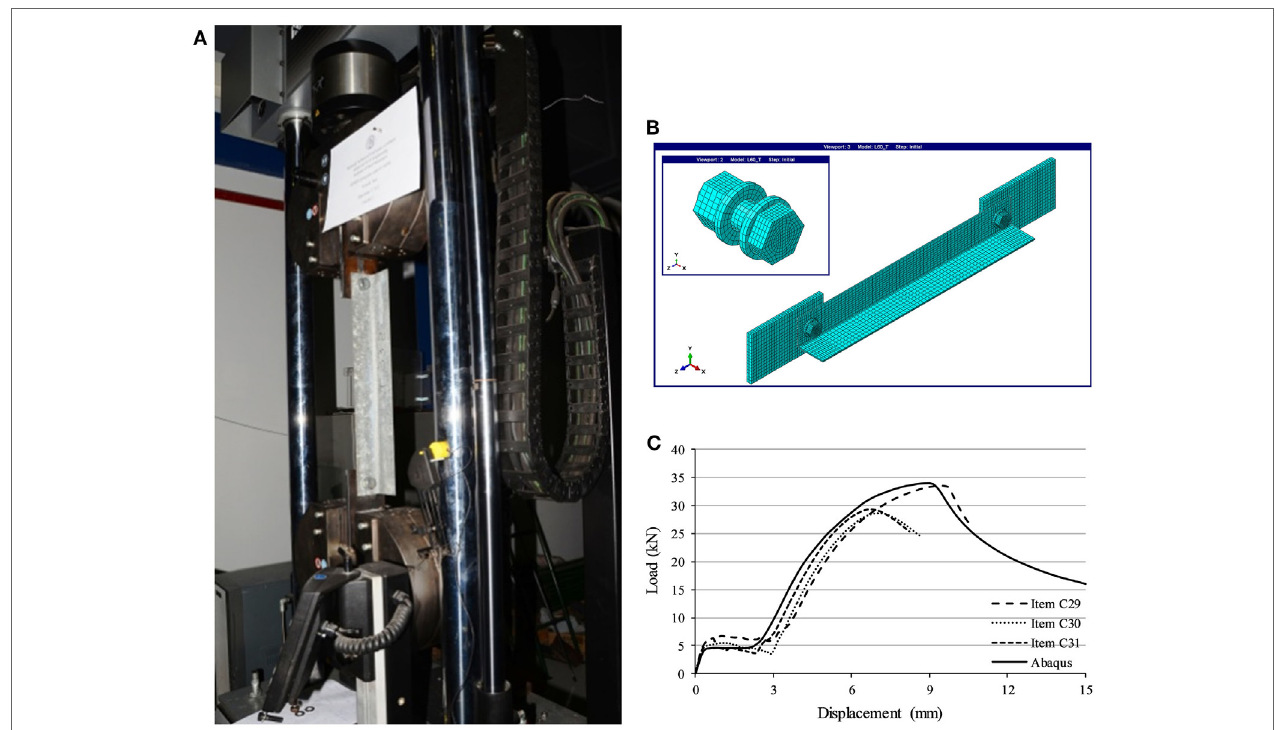
FiGUre 1 | Overall view of (A) the tension set-up and (B) the Abaqus FEM, and (c) comparison of experimental and numerical buckling curves for cross section